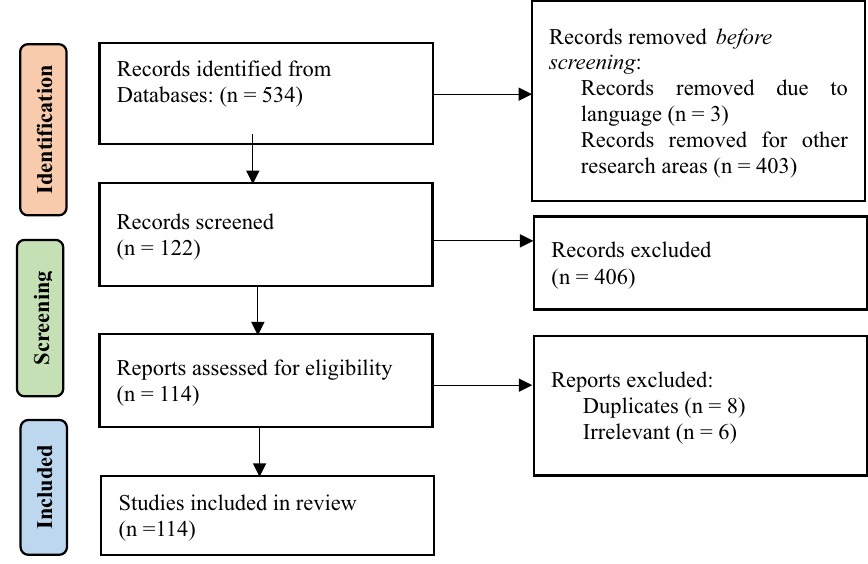
Fig. 2 Research design and